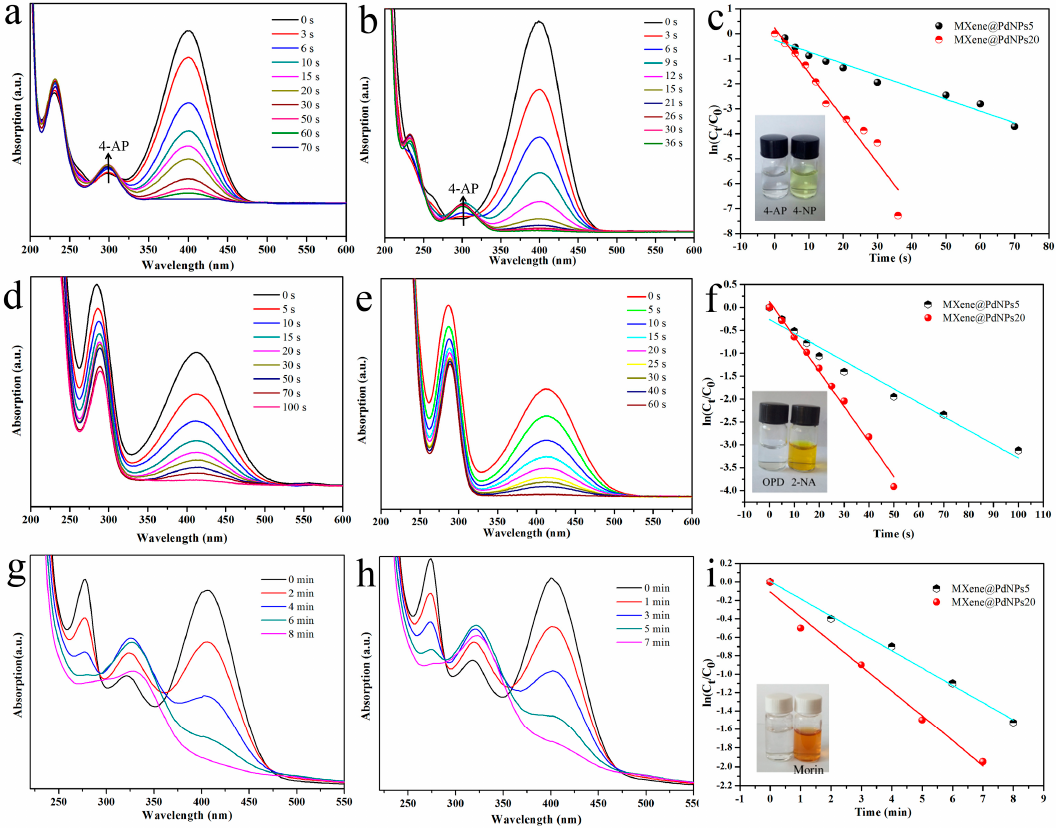
Figure 8. Catalytic reduction of 4-NP, 2-NA and morin by MXene@PdNPs5 composite material ( a , d , g ) and MXene@PdNPs20 composite material ( b , e , h ), respectively; ( c , f , i ) represent the corresponding relationship between the catalytic time and ln(C t /C 0 ) under different catalysts.